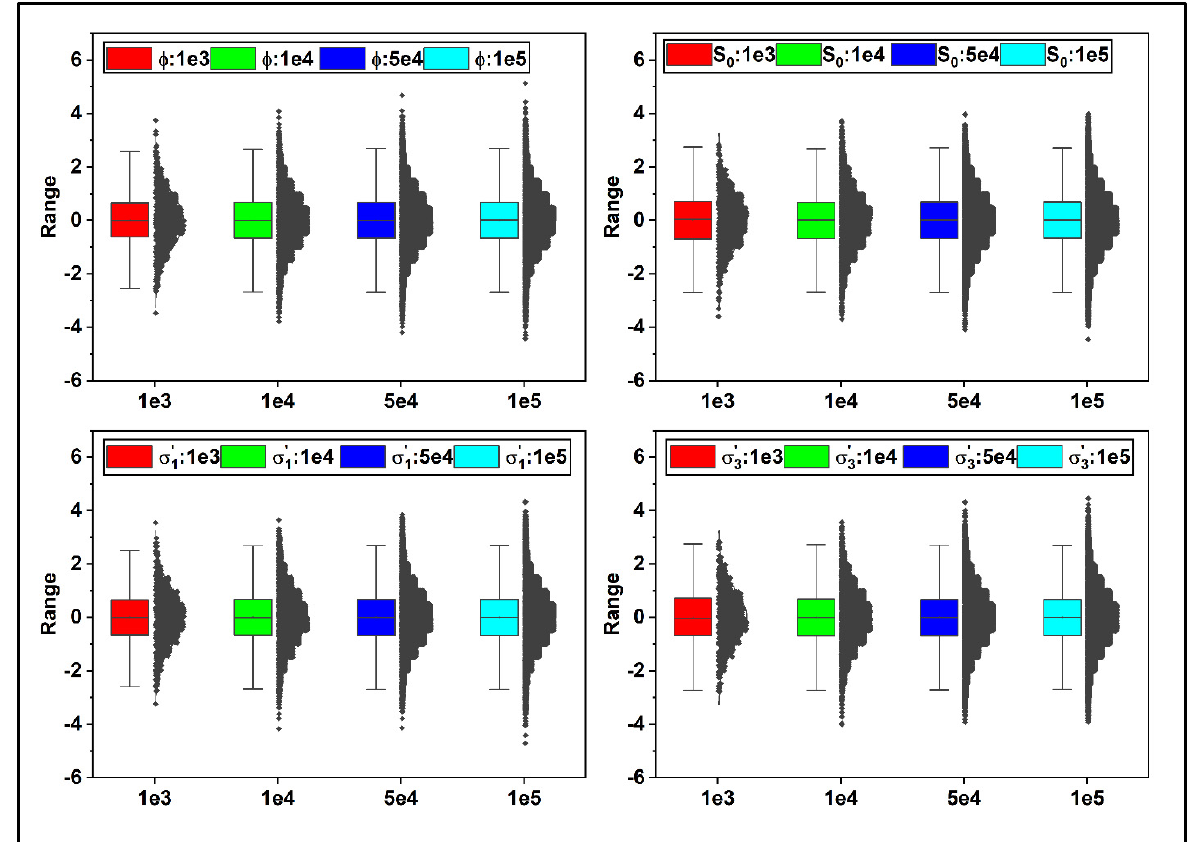
Figure 7. The Graphs depict the Gaussian distributions of ϕ , S 0 , σ ’ 1 , and σ ’ 3 after standardization. The colors red, green, blue, and cyan represent the 1e+03, 1e+04, 5e+04, and 1e+05 sample points. Standardizing involves scaling each input by subtracting the mean value ( λ ) and then dividing by the standard deviation ( μ ) to shift the distribution to have a mean of zero and a standard deviation of one.